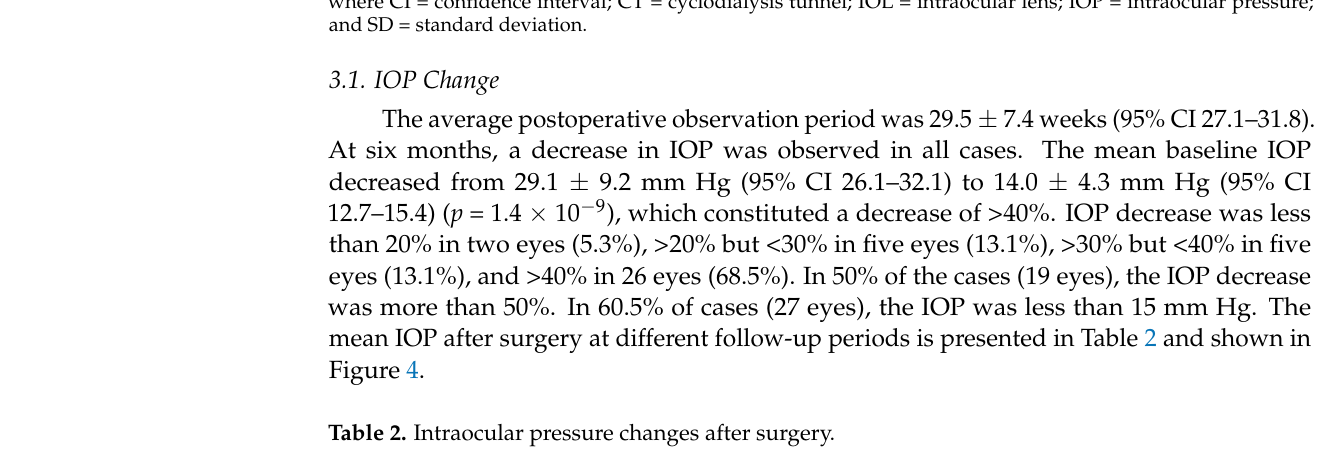
Table 2. Intraocular pressure changes after